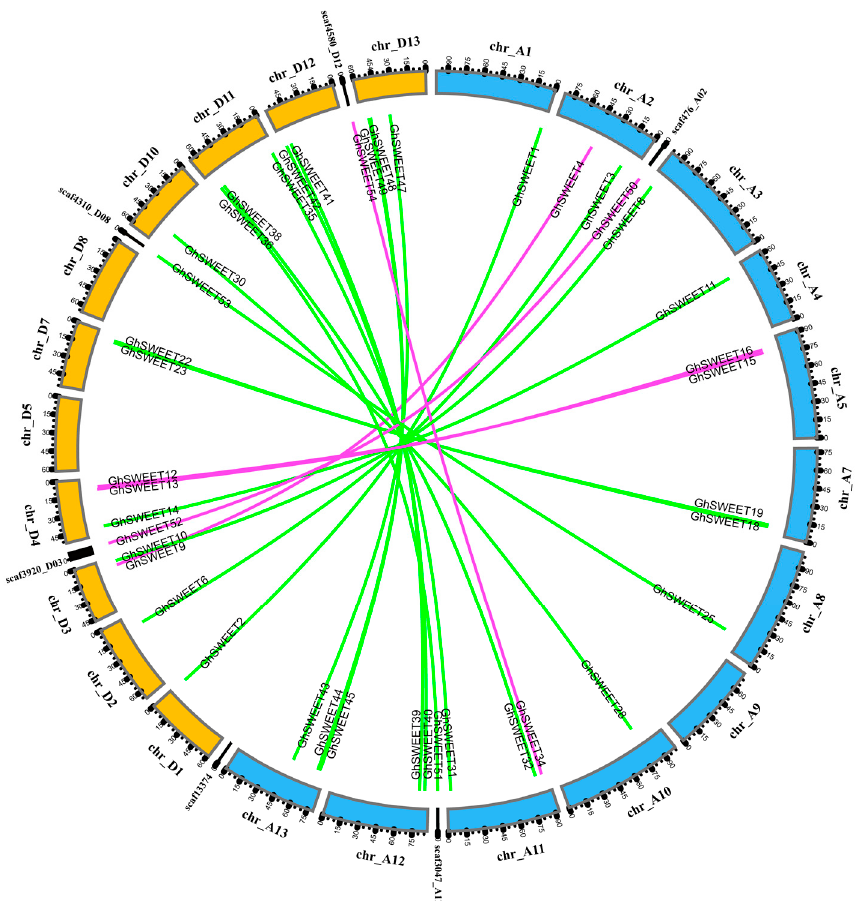
Figure 4. Distribution of paralogous SWEET gene pairs between G. hirsutum At and Dt subgenomes. The 12 At subgenome chromosomes, 11 Dt subgenome chromosomes, and six scaffolds are indicated by different colors, with their names on the periphery. Green lines link the homologous genes located on homoeologous chromosomes in the At and Dt subgenomes. Purple lines link the homologous genes located on non-homoeologous chromosomes in the At and Dt subgenomes and scaffolds.